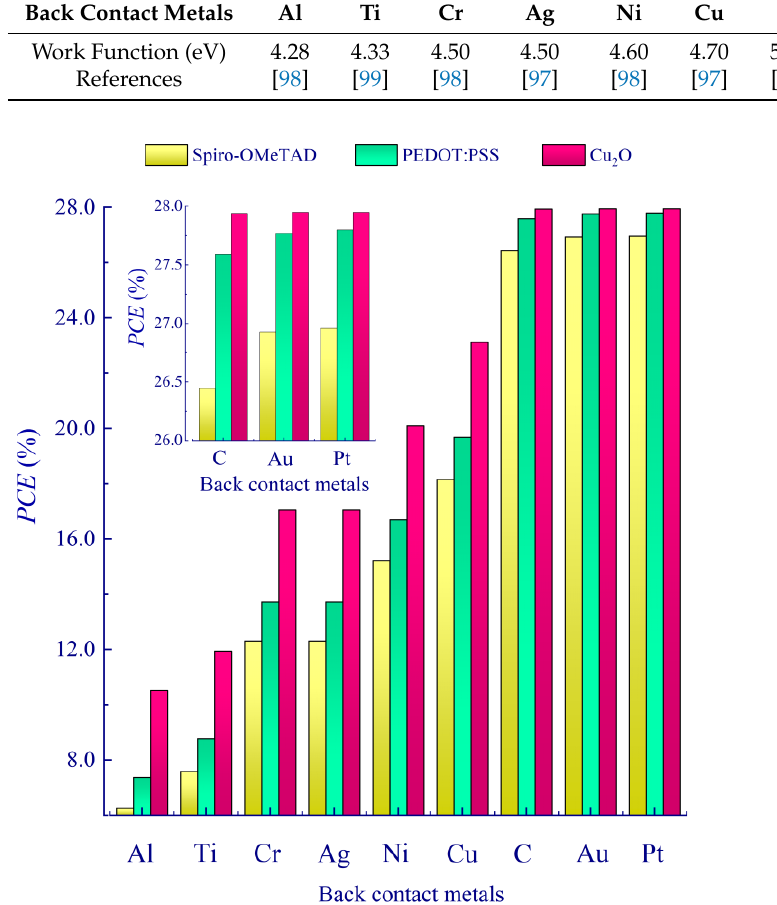
Figure 7. Perovskite solar cells efficiency depending on the choice of a back metal contact.